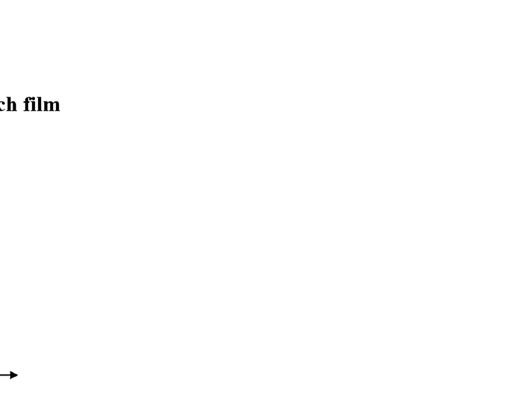
Figure 3. Schematic representation of the working path of the hopper and resulting mulch film damage.